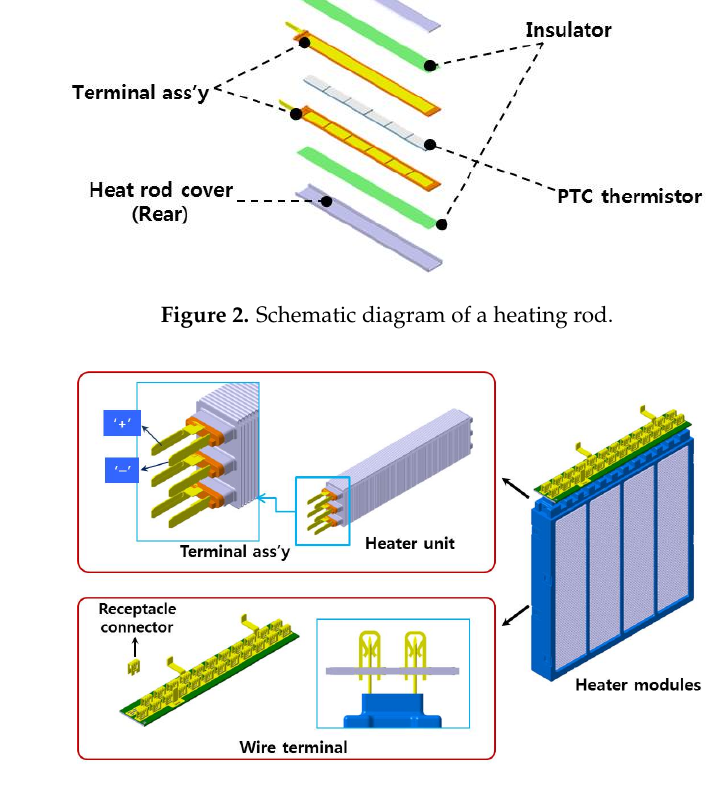
Figure 3. Schematic diagram of the heating unit and modules.